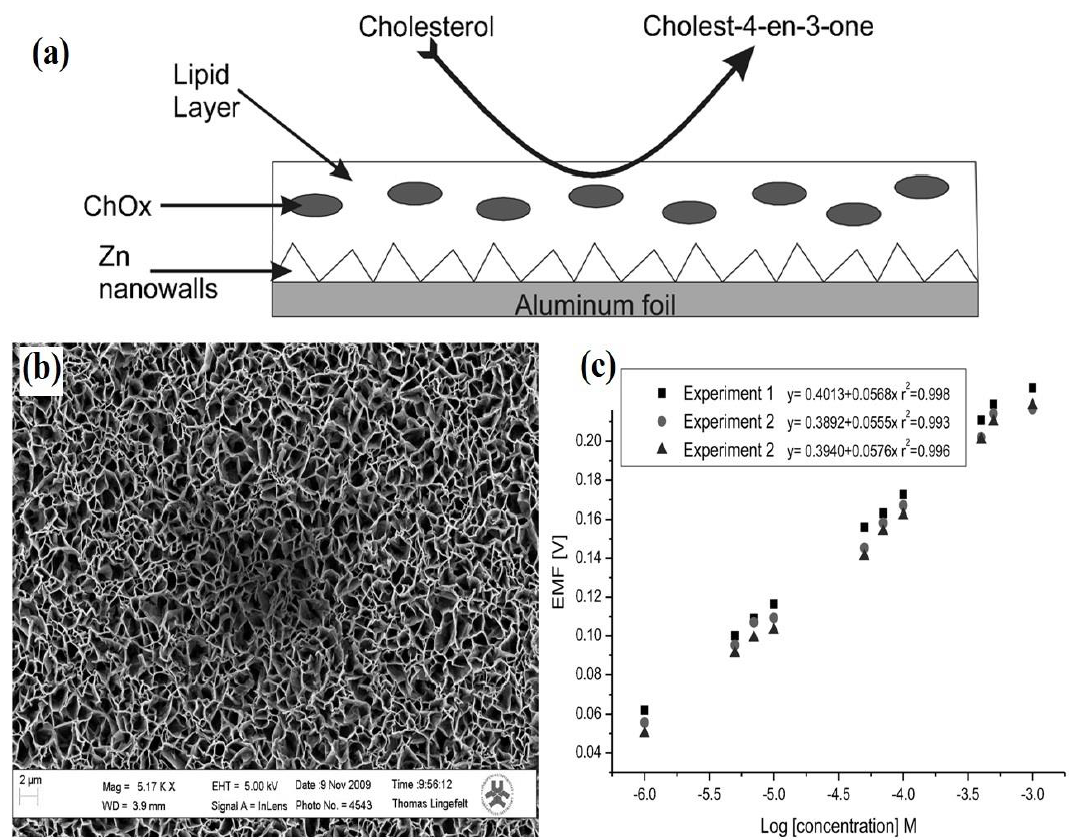
Figure 16. ( a ) Schematic illustration of biosensor design; ( b ) SEM image of ZnO nanowalls; and ( c ) repeated experimental electrochemical calibration curves by using a single biosensor, showing reusability of the biosensor. Adapted by permission from John Wiley and Sons from Ref. [123]. Copyright 2012.